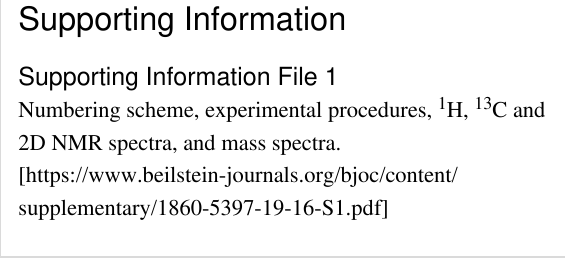
acquired, clarifying the identity and stereochemistry of several